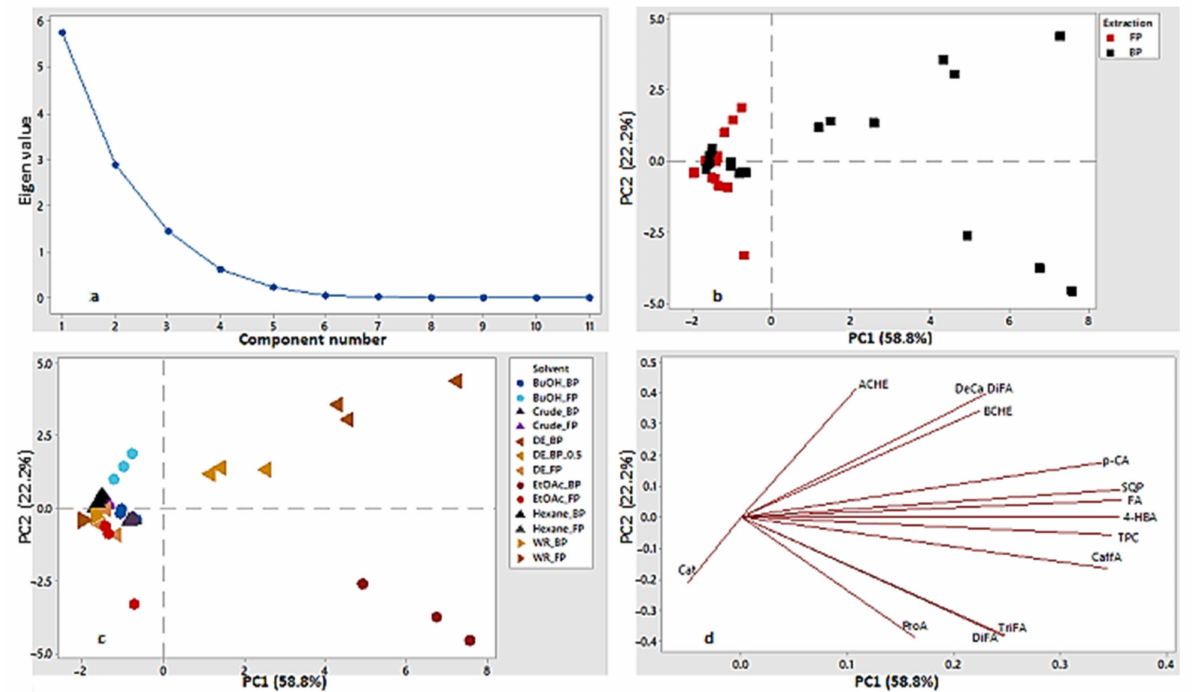
Figure 2. ( a ) Scree plot of BSG FP and BP extracts and fractions; ( b ) Score plot for the first two components (PC) separated by the type of extractions FP and BP; ( c ) score plot for the first two components separated by the type of organic solvent used for fractionation of the FP and BP extracts; ( d ) loading plot of the first two